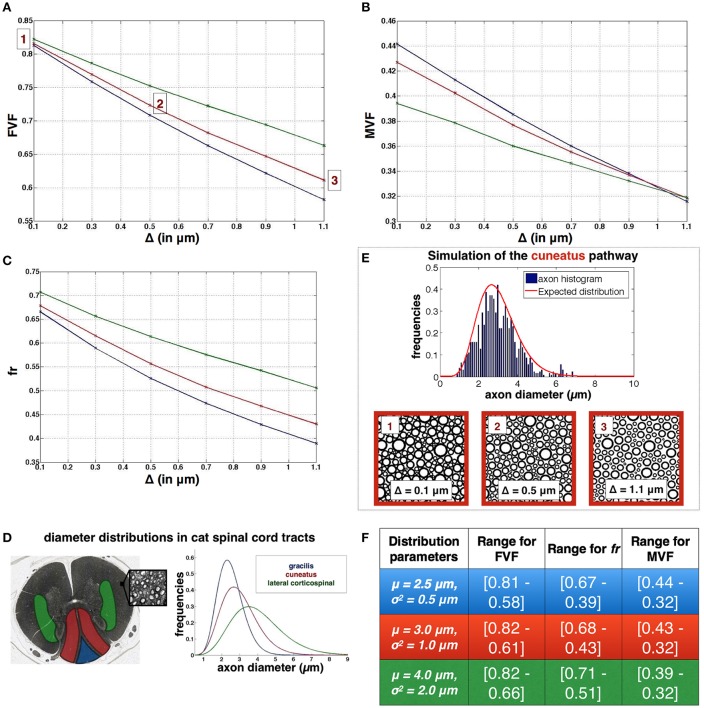
Application for simulating white matter microstructure (A–C). Evolution of FVF, fr and MVF when different gaps between axons Δ are applied. (D) Definition of the three diameter distributions used in the plots, obtained from three spinal regions of a cat spinal cord (blue: gracilis blue, red:cuneatus, green: lateral corticospinal), adapted with permission from Zaimi et al. (2016). (E) Results of axon packing for the cuneatus pathway. Axon diameter histogram and Packing results obtained for three gaps Δ. (F) Ranges of values for FVF, fr and MVF for the three regions: gracilis (first line), cuneatus (second line), lateral corticospinal (third line).